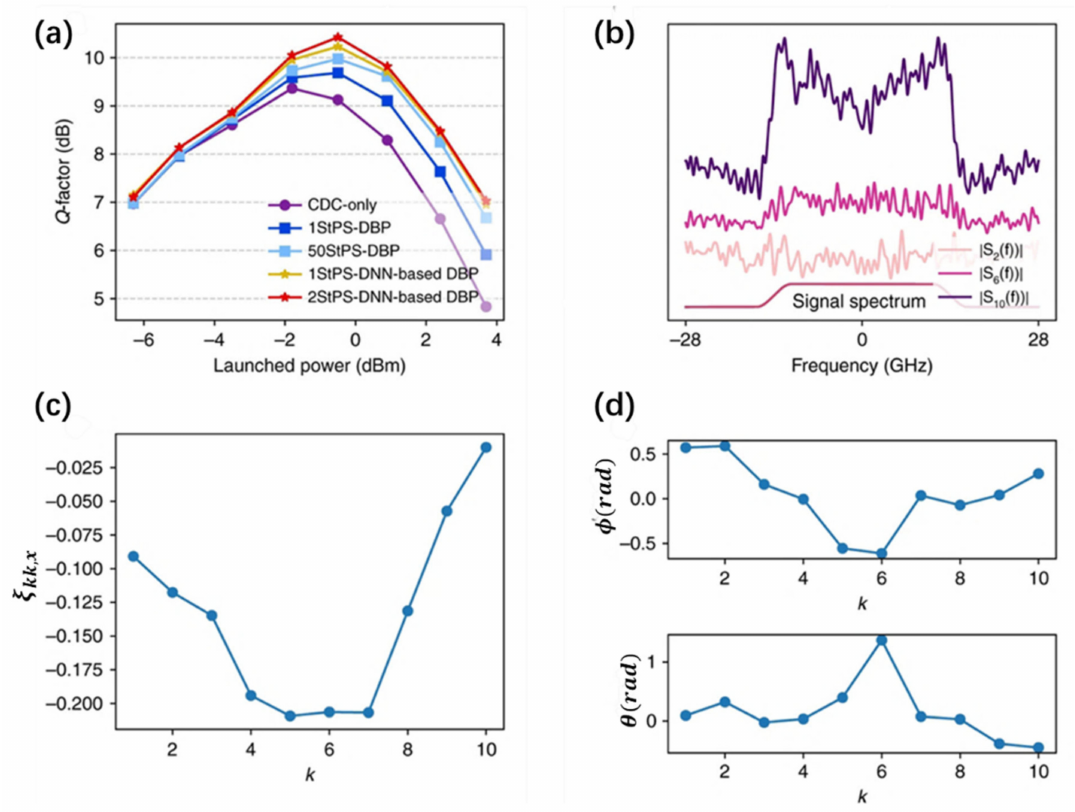
Figure 19. Transmission results for PDM-WDM system. ( a ) Q-factors vs. launch power in different algorithm; ( b ) Optimized amplitude spectra after linear operation in different fiber segment; ( c ) Optimized nonlinear coefficients in different fiber segment; ( d ) Optimized rotation angle for